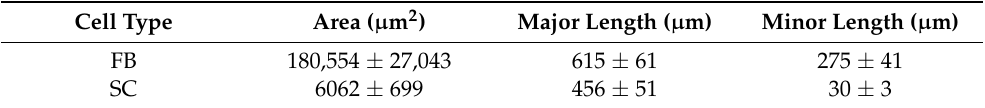
Table 1. Morphometric parameters of SC and FB. Evaluation of the area, major and minor length of Schwann cells (SC), and fibroblasts (FB) of +/+ and TrJ/+ cultures. Measurements expressed in Mean ±